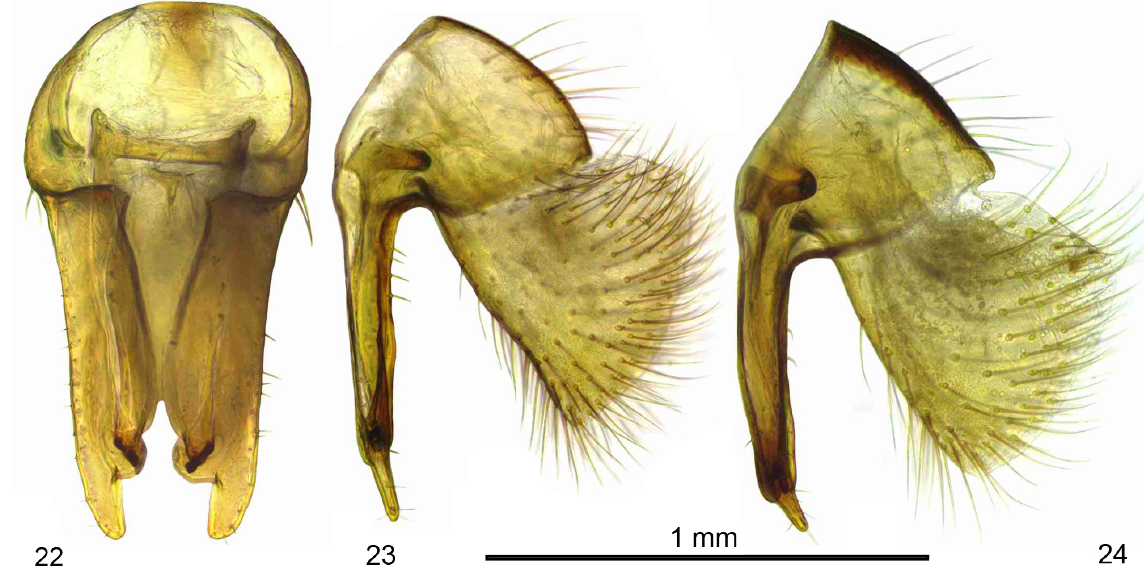
Figs 22–24. Ichneumonopsis spp., epandrium. 22 . I. burmensis Hardy, 1973, anterior view. 23 . I. burmensis Hardy, 1973, lateral view. 24 . Ichneumonopsis taiwanensis sp. nov.,